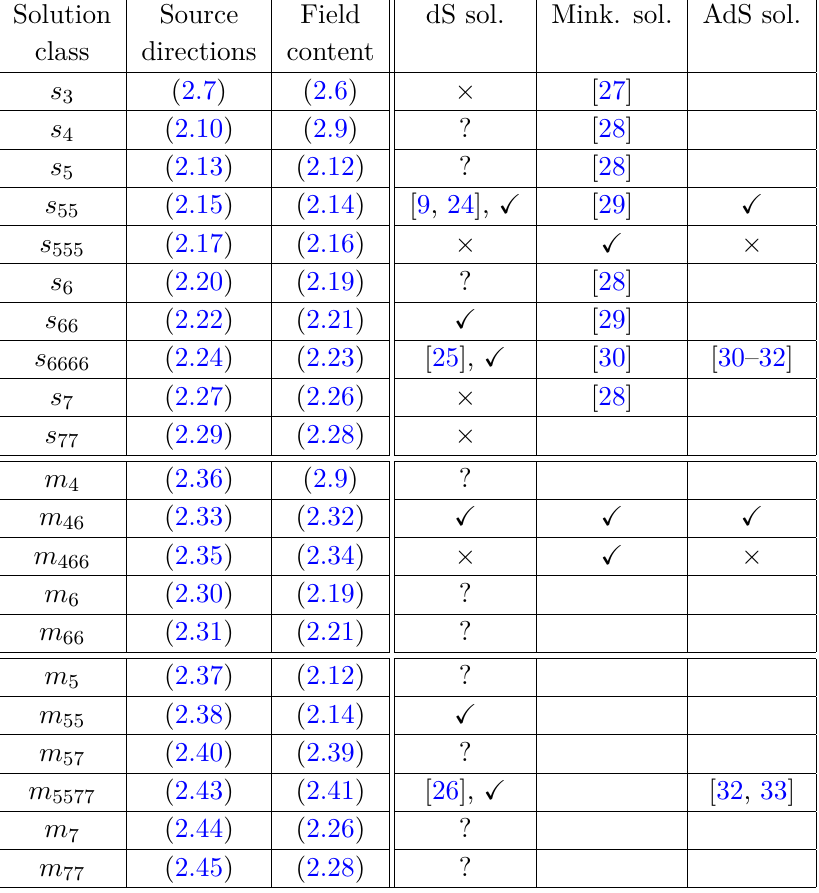
Table 1 . Classification of solutions on 4d maximally symmetric spacetimes with orientifold, within our ansatz. The solution classes are labeled with s for O sources of single dimensionality, and p /D p m for multiple ones. The subscript corresponds to the dimensionalities of the O p : for instance s 6666 means there are only O 6 and D 6 , and 4 intersecting source sets with O 6 . The details of the source configurations and the allowed field variables under the projections are given in corresponding equations. We further list for each solution class few references where explicit solutions were